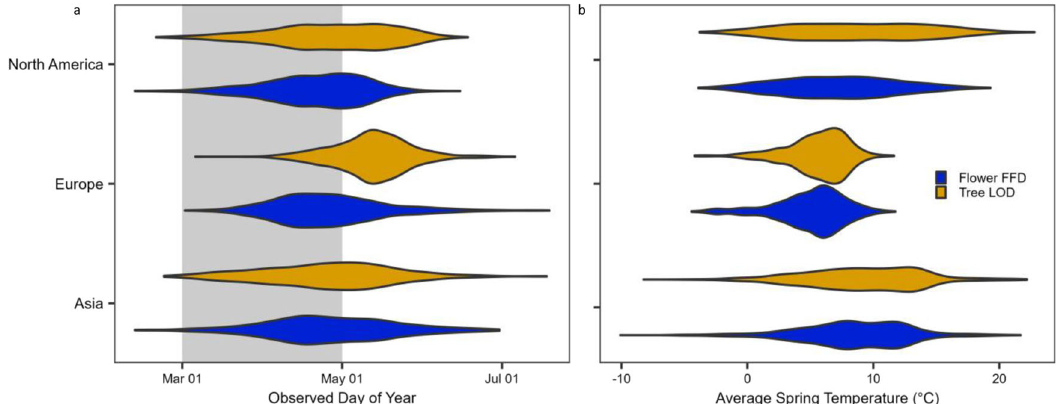
Fig. 1 | Distributions of observed phenology in the herbarium record by (a) observeddateofphenologyand(b)averagespring(March – April)temperature (°C). Distributions of observed understory wild fl ower First Flowering Date (FFD;